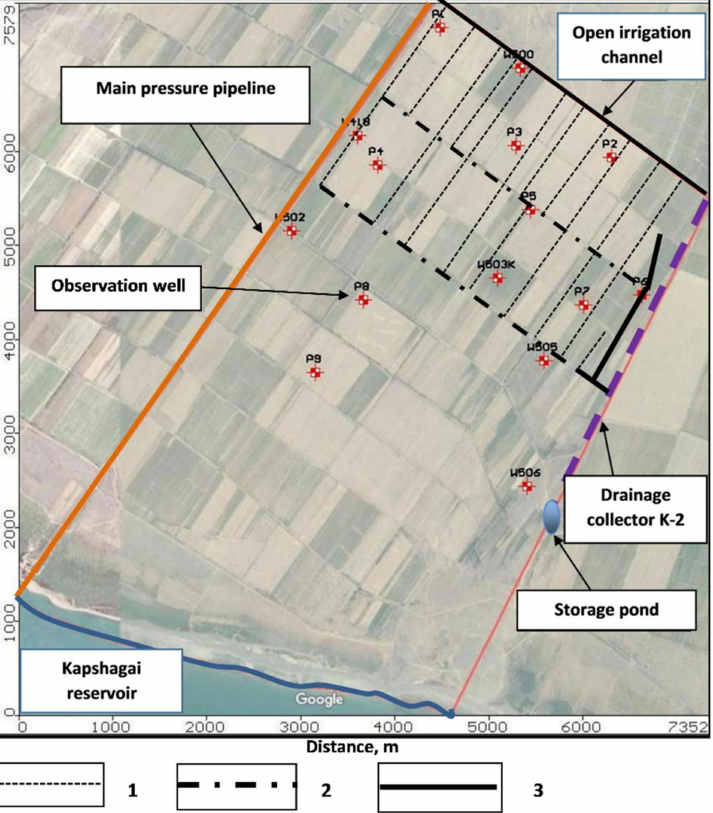
Figure 2. The experimental site collector-drainage system: (1) horizontal subsurface drainage; (2) main subsurface drainage; (3) close